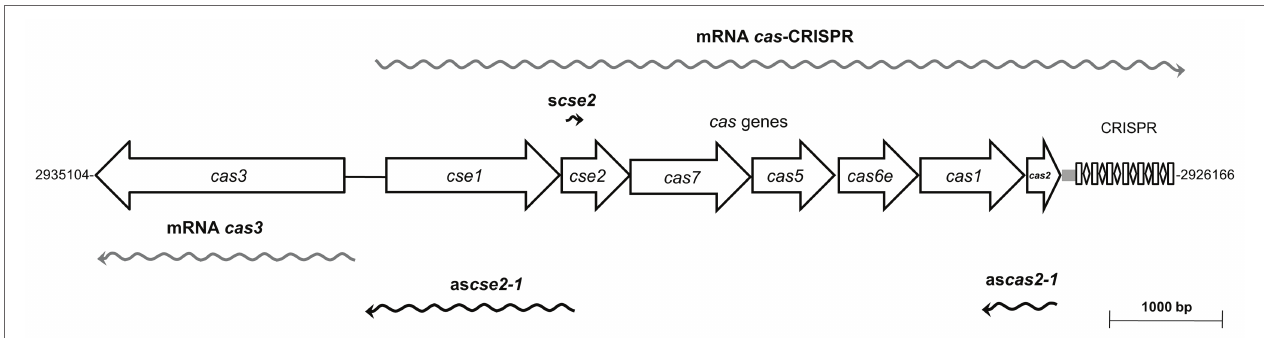
FIGURE 1 | Transcriptional organization of the Type I-E CRISPR-Cas system of Salmonella enterica serovar Typhi IMSS-1. The CRISPR-Cas system is composed of eight cas genes ( cas3 and cse1-cse2-cas7-cas5-cas6e-cas1-cas2 ), a leader of 84 bp and the CRISPR1 array, containing seven 29-bp repeats and six 32-bp spacers. Five transcriptional units are transcribed from this locus, wavy gray arrows represent mRNAs of cas -CRISPR operon and cas3 , whereas the RNA s cse2 , the antisense as cse2-1 and as cas2-1 are shown as wavy black arrows. The Salmonella Typhi Δ CRISPR- cas strain is devoided of the entire Type I-E CRISPR-Cas system (from cas3 to CRISPR